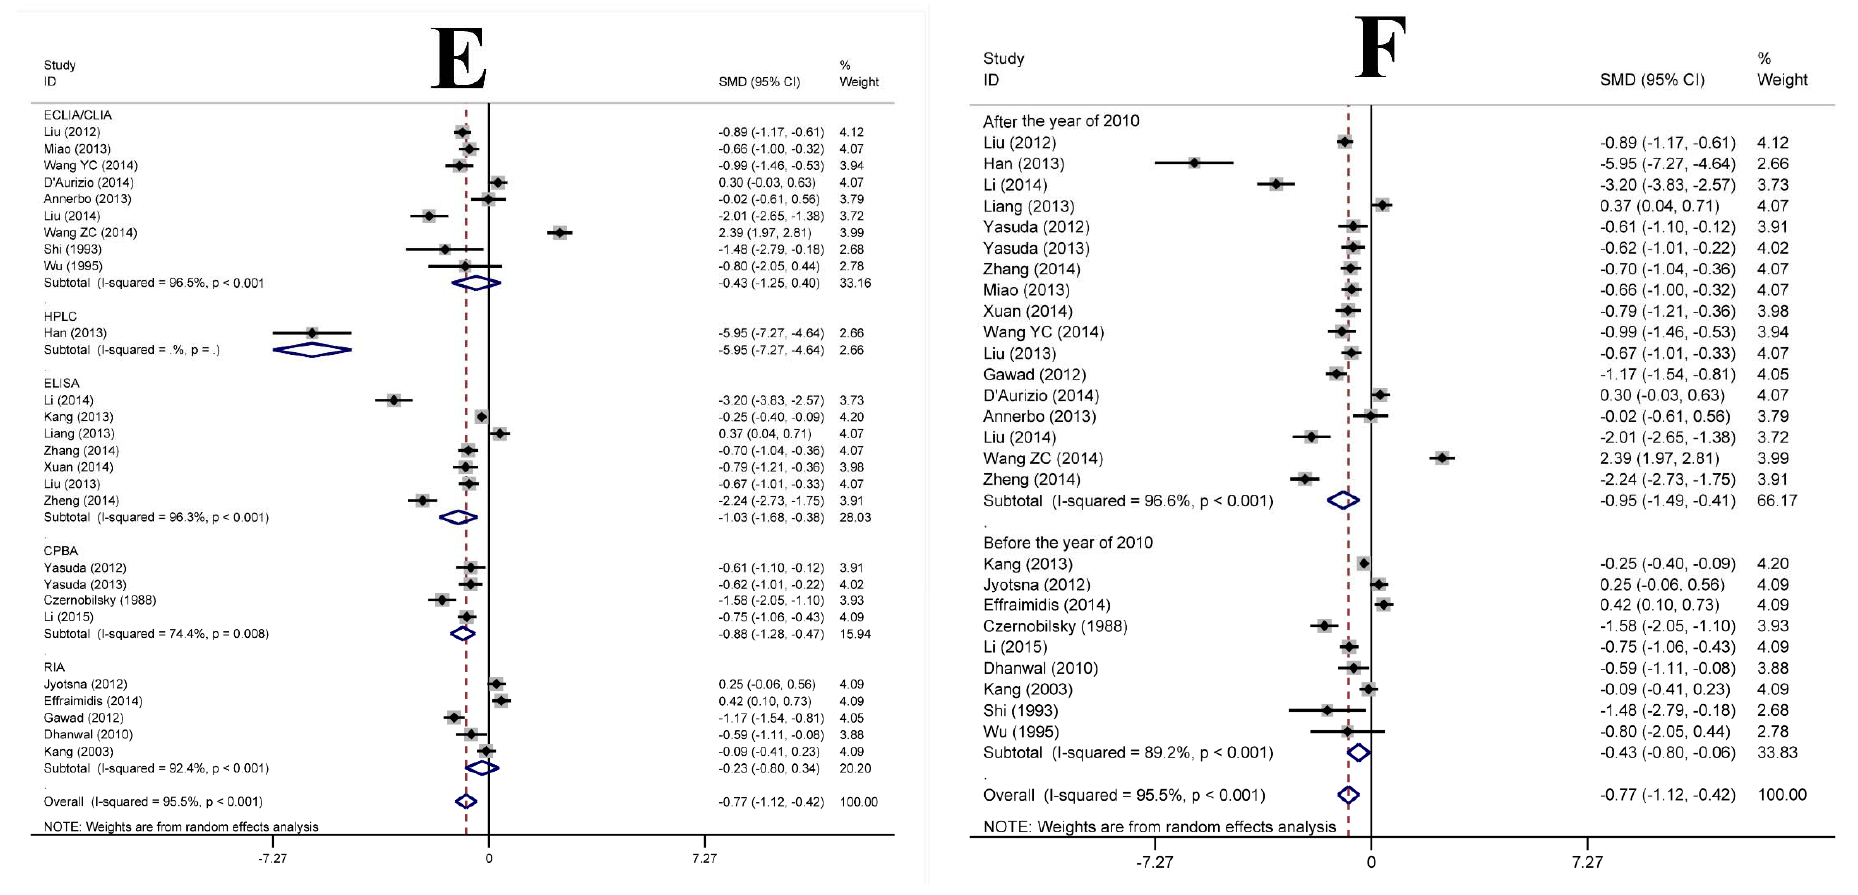
Figure 3. Forest plot of the studies comparing the association between vitamin D levels and Graves’ disease in the subgroups by meta-analysis with the random effects analysis. SMD, standardized mean differences; ( A ) mean age group; ( B ) geographic location; ( C ) country type; ( D ) detection index; ( E ) assay method; ( F ) study